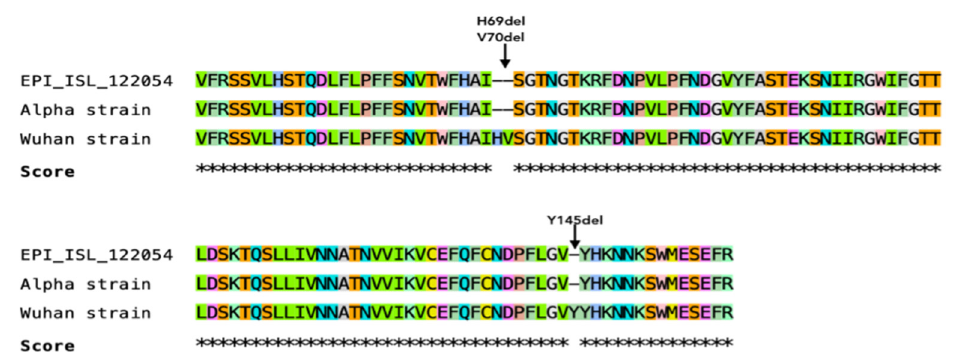
Figure 3. Clustal W analysis of partial Spike genome sequence retrieved in dog (EPI_ISL_122054) compared to Alpha and Wuhan strain.